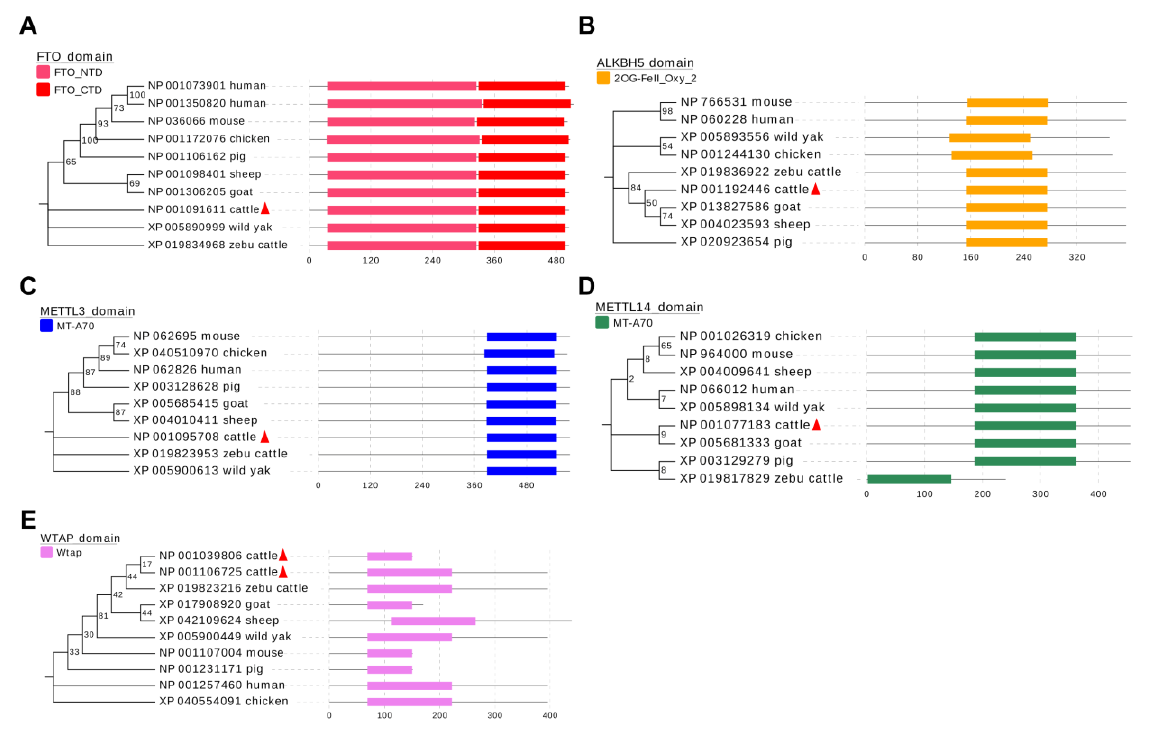
Figure 7. Phylogenetic tree and conserved function domains in the m 6 A methylases. ( A ) FTO, ( B ) ALKBH5, ( C ) METTL3, ( D ) METTL14 and ( E ) WTAP, visualized using MEGA7 software and the EvolView online tool.